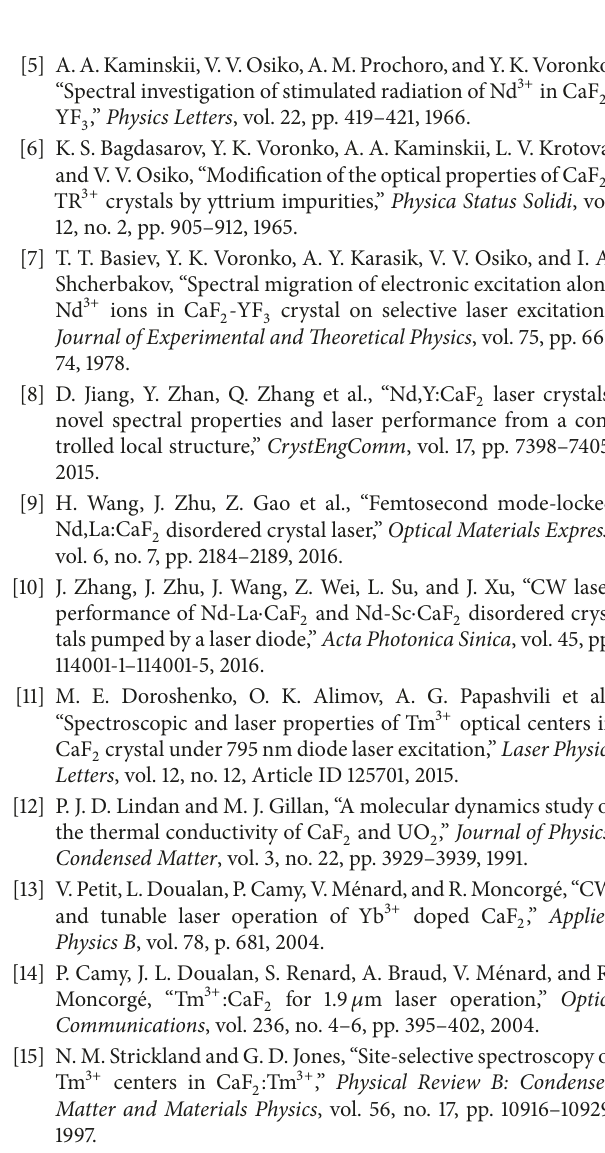
Figure 6: Schematic of the experimental setup for 1.8 𝜇 m laser operation.